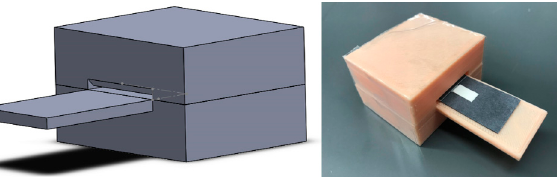
Figure 9. A 3D-printed holder that allows for a reproducible folding of the paper-based device. This holder can be integrated into a portable imaging platform that can be used in the